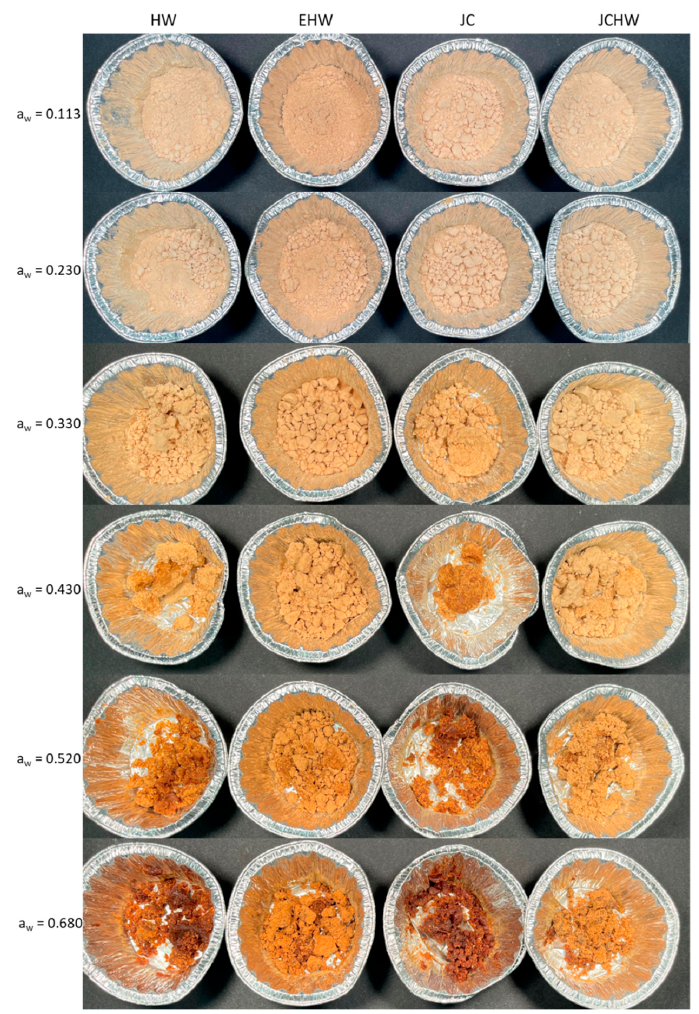
Figure 2. Powder photographs after three months of storage at different water activities. HW: hot water; EHW: extrusion + hot water; JC: jet cooker; JCHW: jet cooker + hot water. Hue angle values in all cases increased with increasing water activity, showing that colours tended to be more yellowish in lower water activities, and as water content in- creased, the colour became more reddish. By combining these results, it is concluded that when water activity increases, the powders tend to be more brownish (lower luminosity values and more reddish). This has also been seen in the case of pumpkin powder [25].